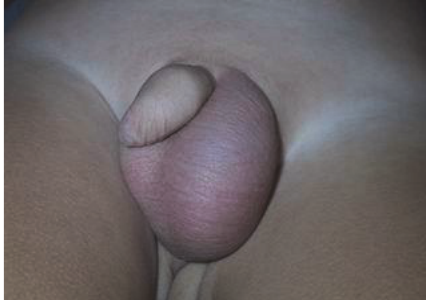
Figure3:Leftscrotumsurgicalexplorationshowinghydrocelefilled withbloodyfluidandrotated360degrees(arrow),withnormaltestis and